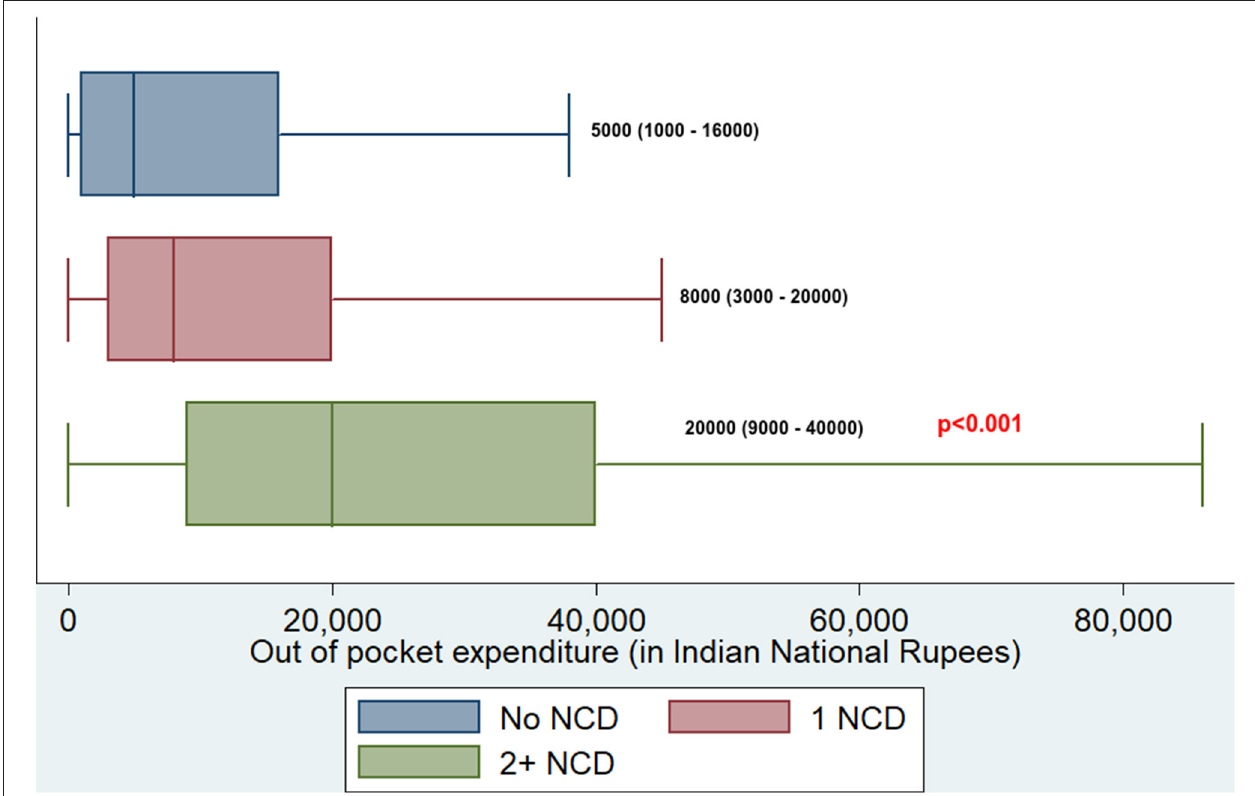
FIGURE 3 | Boxplot depicting median OOPE along with interquartile range among those having no NCD, one NCD, and NCD multimorbidity in adults residing at HDSS, Gorakhpur (overall, N = 14,032; no NCD, n = 5,078; 1 NCD, n = 7,625; 2 + NCD, n = 1,329). NCD, noncommunicable